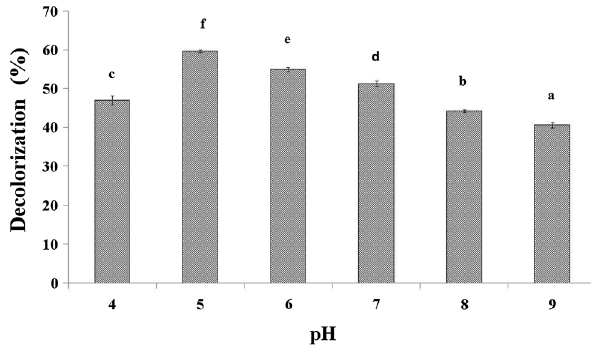
Fig. 6 Effect of initial